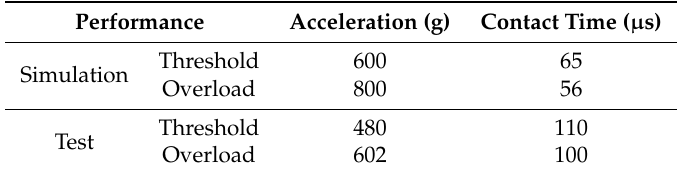
Figure 12. ( a ) The threshold acceleration curve and trigger signal. ( b ) The overload acceleration curve and trigger signal. Table 2. The simulation and experimental results of designed inertial micro-switch.